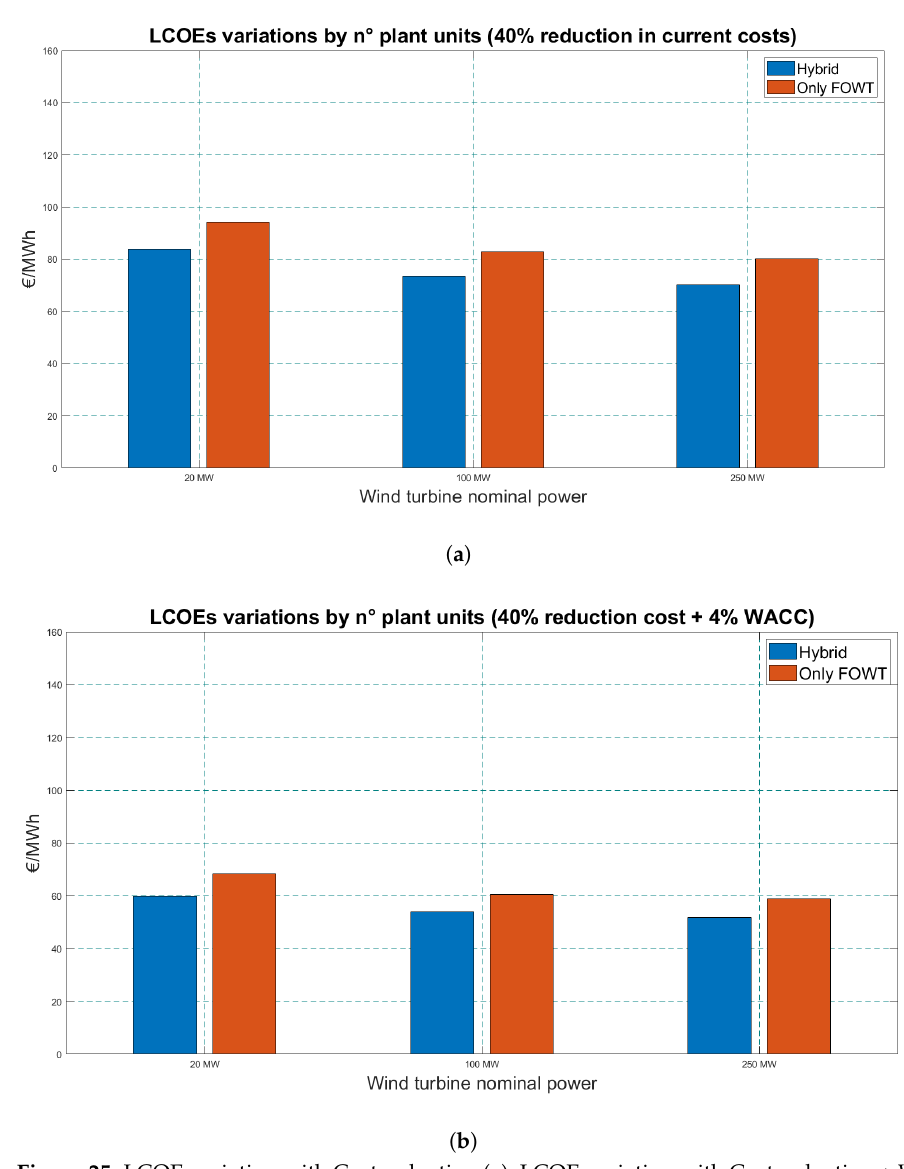
Figure 25. LCOE variation with Cost reduction ( a ), LCOE variation with Cost reduction + WACC set at 4% ( b